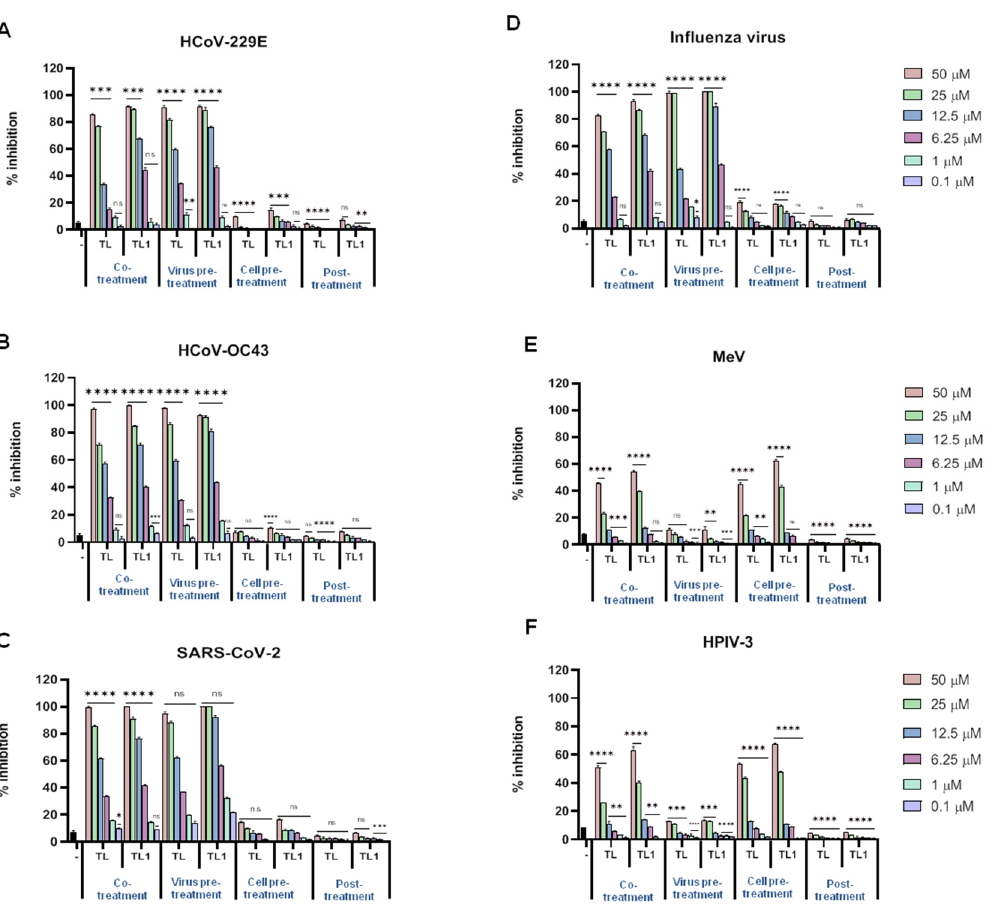
Figure 3. Antiviral activity of TL and TL1 against enveloped RNA virus. Peptides were added in four different “time-of-addition” experiments and their antiviral potential has been analysed against ( A ) HCoV-229E; ( B ) HCoV-OC43; ( C ) SARS-CoV-2; ( D ) Influenza virus; ( E ) MeV; and ( F ) HPIV-3. **** p < 0.0001; *** p < 0.001; ** p < 0.01; * p < 0.1; ns: nonsignificant. – indicates the infected and not treated cells.